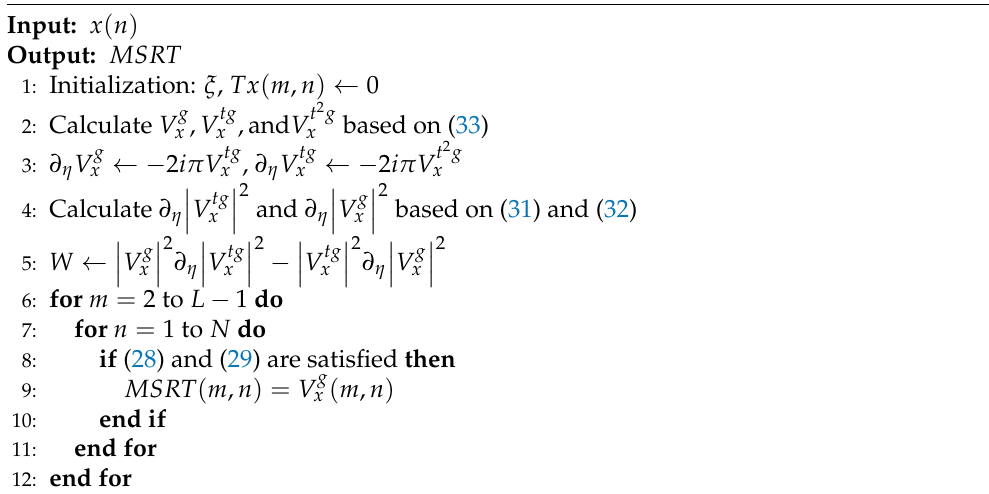
Algorithm 1 Fast calculation of the discrete